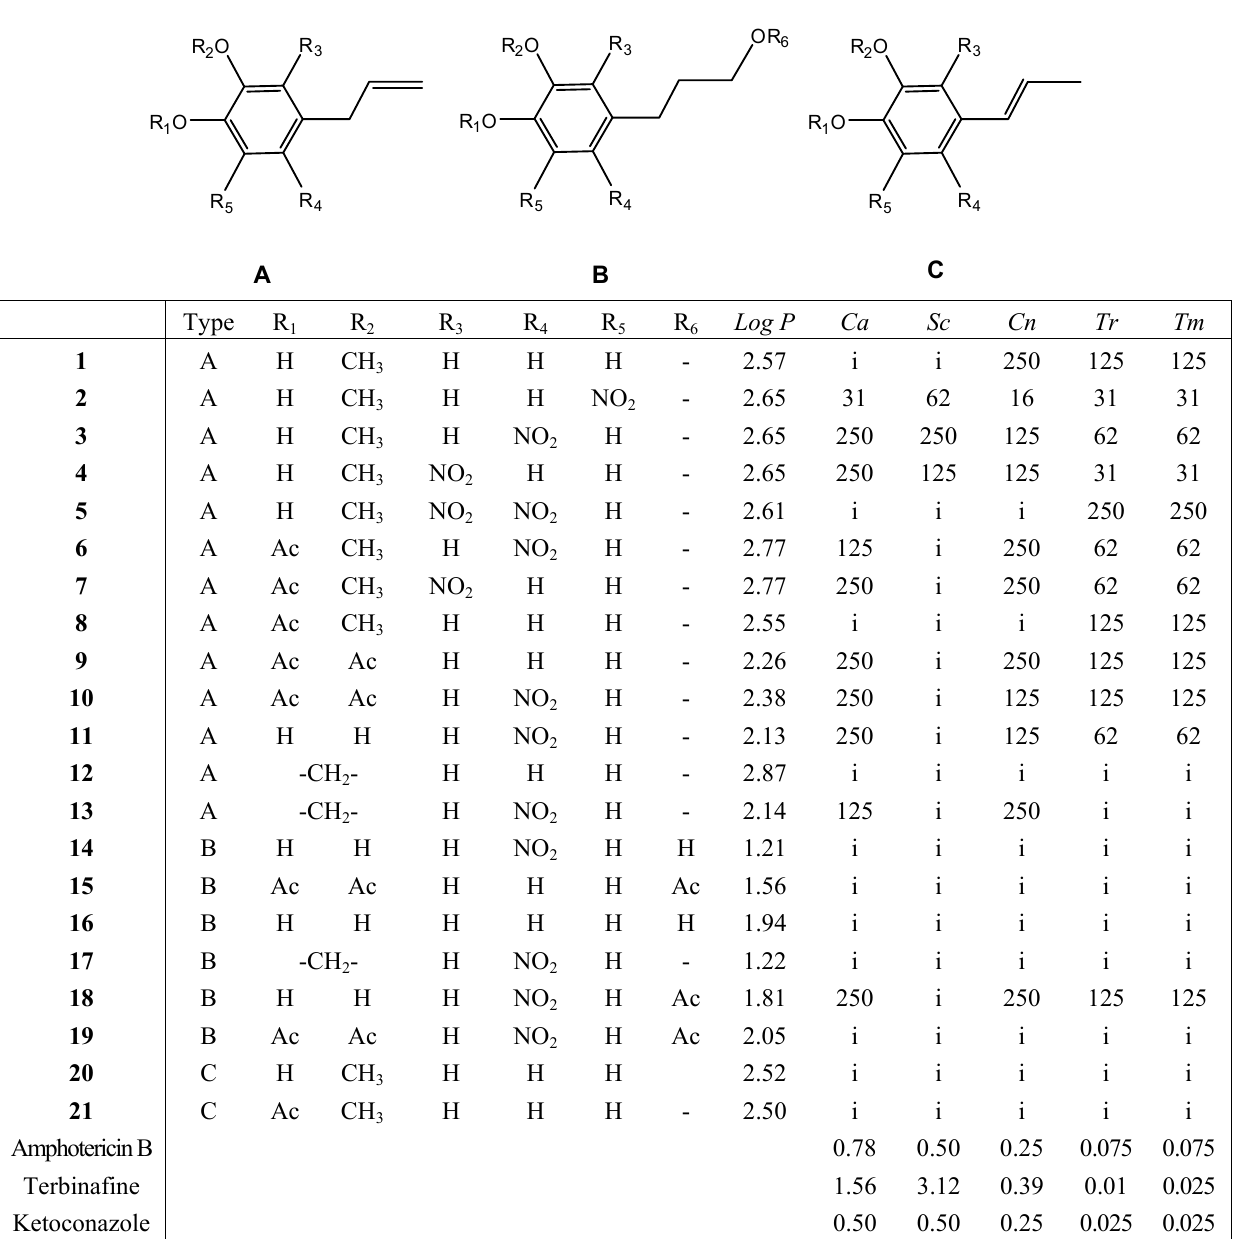
Table 1. MIC values (µg mL − 1 ) of eugenol ( 1 ) and analogues 2 – 21 against human opportunistic pathogenic